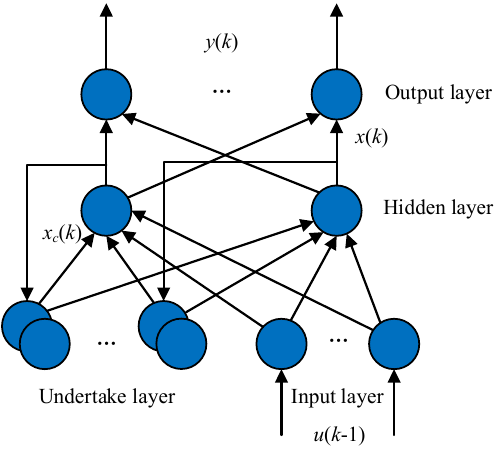
Figure 7. Architecture of Elman neural network.